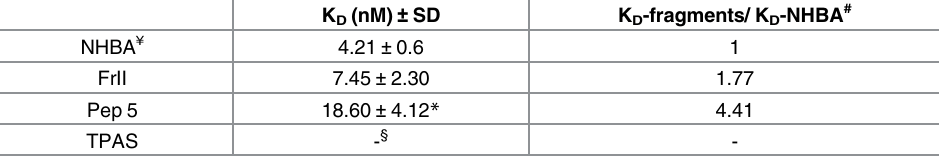
# K D variation, compared with the full-length antigen, is shown as x-fold obtained from the ratio K D -fragments/ K D -NHBA * Signi fi cantly different (p < 0.05) from NHBA by ANOVA and Student-Newman-Keuls test using data from 4 independent experiments § No interaction was detected under the tested conditions ¥ abbreviations:NHBA, full-length fusion antigen including NUbp and an histidine tail;FrII, GST-FrII fusion protein;Pep 5, Peptide 5 (shown in Fig 5A);TPAS, tetrapeptide with the consensus TPAS amino acid